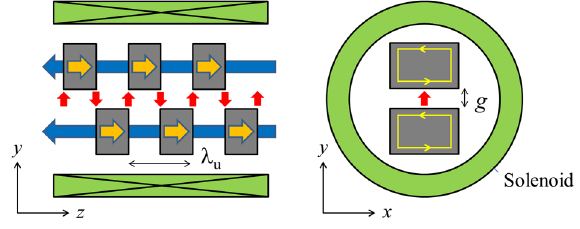
FIG. 1. Schematic view of